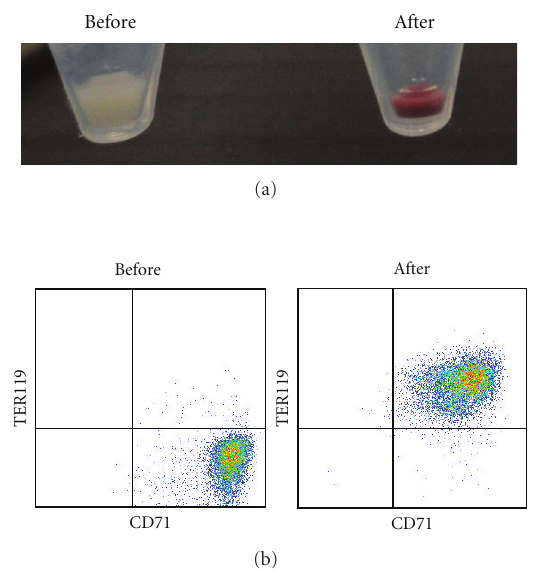
Figure 3: In vitro di ff erentiation of a MEDEP cell line, MEDEP- BRC5. MEDEP-BRC5 cells cultured continuously for more than one and a half year was analyzed. The in vitro di ff erentiation of MEDEP-BRC5 was performed by culture for four days after deprivation of stem cell factor and addition of erythropoietin. (a) Cell pellets before and after in vitro di ff erentiation. Red cell pellet indicates abundant hemoglobin production in the cells. (b) Flow cytometric analyses. Before and After, the cells before and after in vitro di ff erentiation; CD71, transferrin receptor; TER119, a cell surface antigen specific for mature erythroid